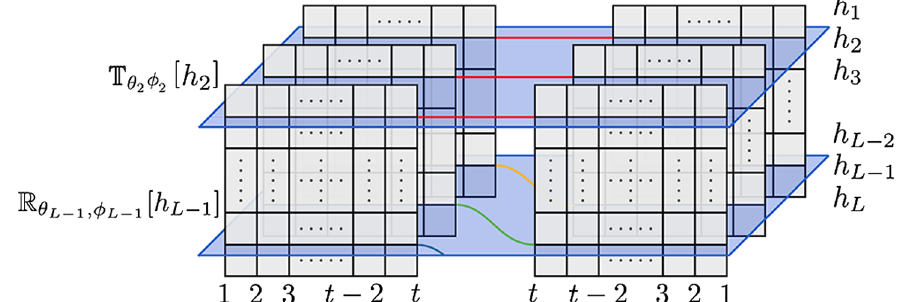
t ÞÞ 3 (cid:2) written according to Eq. (44). Positive and negative time sheets are, respectively, on the left .FIG. 5. Schematic depiction of tr ½ð ρ A ð and on the right. Vertices connected by the colored lines are coupled by the transfer matrices, in analogy with Fig. 4. Blue-shaded h (cid:2) for the physical sites corresponding to the block A horizontal planes denote the spatial transfer matrices, specifically, the operator T θ ; ϕ ½ h (cid:2) ¼ PT θ h (cid:2) P † for the sites corresponding to L − N spins in A c of N spins and the operator R θ ; ϕ ½ ; ϕ ½